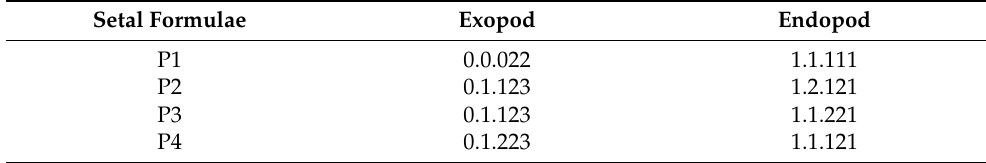
Table 2. Armature formulae of legs